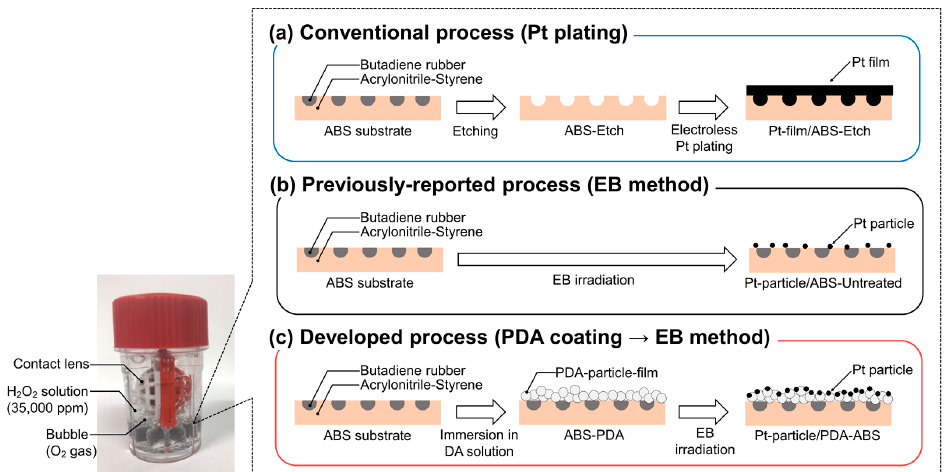
Figure 1. Schematic of the processes for preparing ( a ) a Pt-film/ABS sample by the electroless plating method, ( b ) a Pt-particle/ABS sample by EBIRM without pre-treatment, and ( c ) a Pt-particle/ABS-PDA sample by EBIRM adding a PDA coating as a pre-treatment.